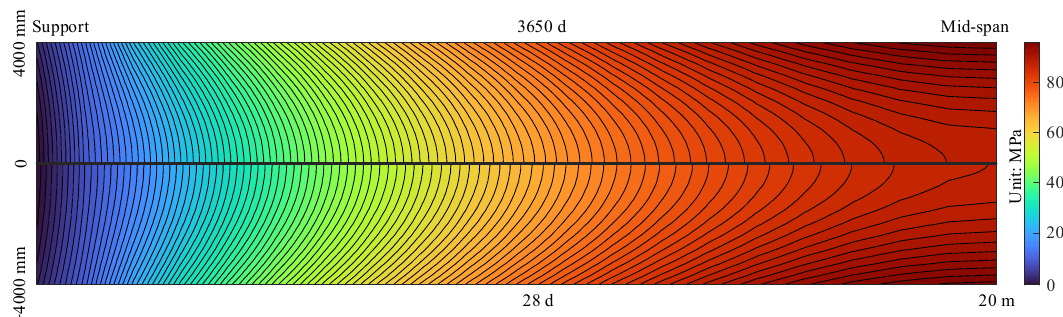
Figure 19. Contour plot of stresses on the concrete slab of the composite beam.